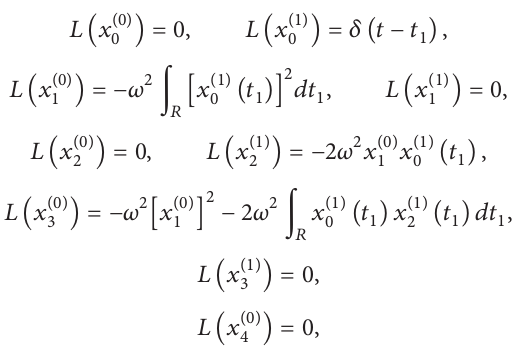
approximation and different number of corrections